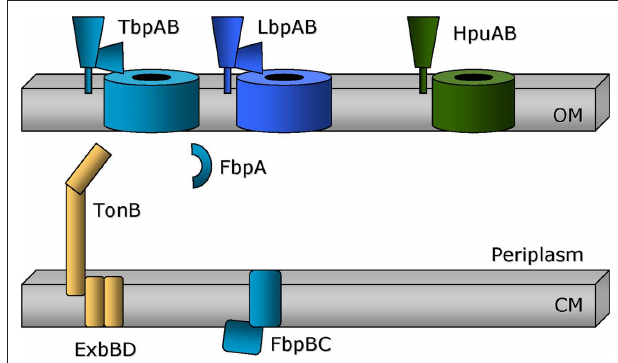
Figure 1 | Two component gonococcal systems for acquisition of iron from host proteins. The TonB dependent outer membrane transporters are shown as barrels traversing the outer membrane (OM). The lipid-modified companion proteins are shown tethered to the outer membrane surface. TonB, ExbB, and ExbD (gold) are depicted as attached to or imbedded within the cytoplasmic membrane (CM). The periplasmic binding protein, FbpA, is responsible for transporting iron from the outer membrane transporters, TbpA and LbpA, to the cytoplasmic membrane permease, comprised of FbpB. FbpC is the ATPase that energizes transport